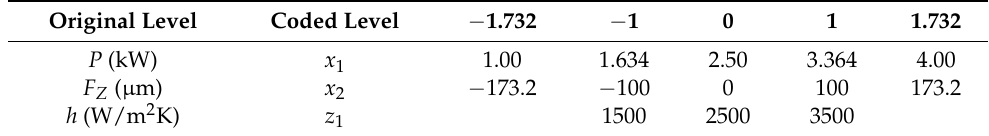
Table 2. Design variables and their coded levels.